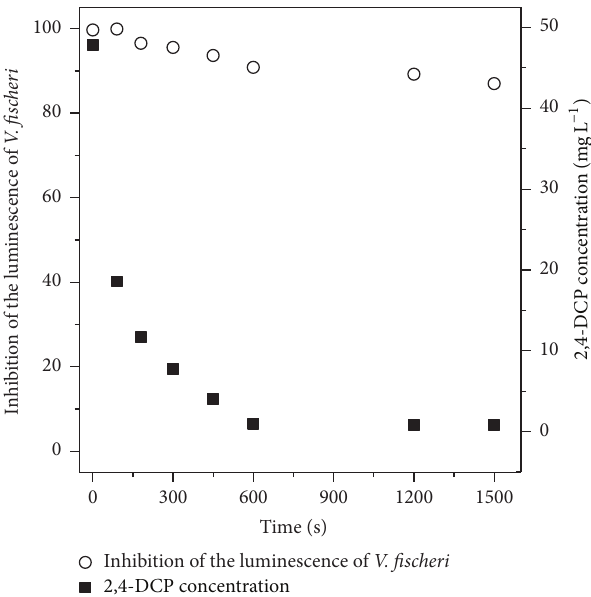
Figure 9: Toxicity analysis of 2,4-DCP photosensitized oxidation.